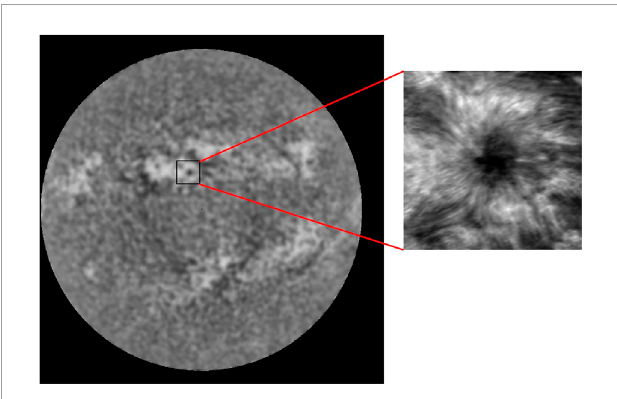
FIGURE 1 ALMA images of the Sun at 1.3 mm (band 6). Left: Full disk image obtained by scanning with a single dish; the spatial resolution is 30 ′′ . Right: High resolution (1 ′′ ) image of the region around the sunspot, obtained in interferometric mode with mosaicking. Both images were obtained on 18 December 2015, during the commissioning period and were processed by the authors for better visibility of the disk